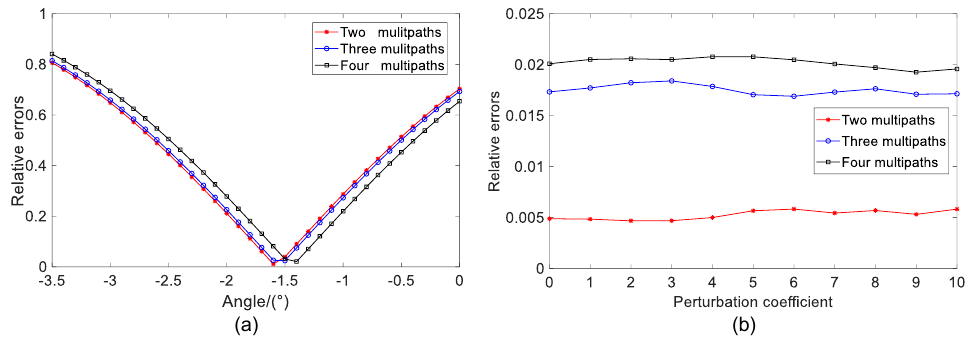
Figure 3. The equivalent multipath relative error results of smooth reflection. ( a ) The equivalent multipath relative errors at different angles. ( b ) The equivalent multipath relative errors at different β